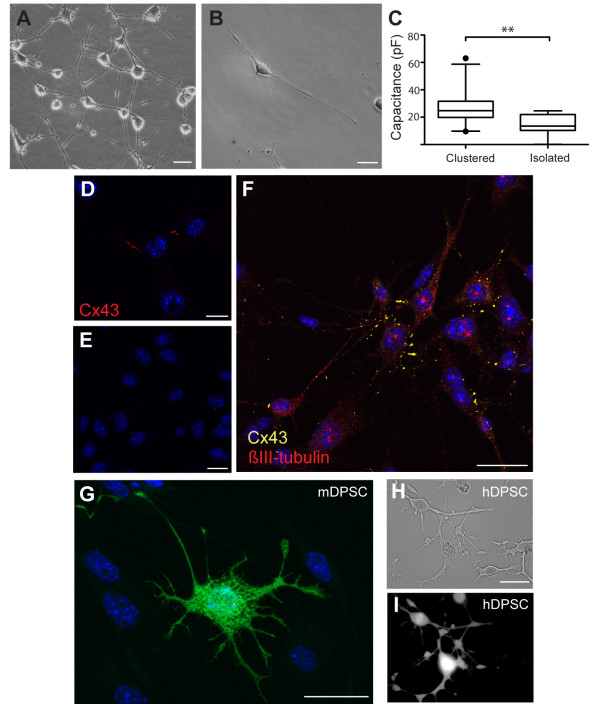
Network connectivity of differentiated mDPSC. Representative images of differentiated mDPSC in a cluster of many cells (A) and as an isolated unit (B). C) Capacitance of clustered cells (n = 23) was significantly greater than isolated cells (n = 12) measured by whole cell patch clamp analysis. IHC shows mDPSC expression of connexin 43 (Cx43) in differentiated (D) but not undifferentiated cells (E). F) Cx43 (yellow) is most highly expressed within clusters of ßIII-tubulin (red) positive differentiated mDPSC (iii). G) Image of a clustered mDPSC injected with Lucifer yellow and neurobiotin does not show any dye coupling with adjacent cells. Lucifer yellow injection into a clustered differentiated human DPSC does show dye coupling through numerous adjacent cells observed under bright field (H) and ultraviolet light (I). Scale bar = 25 μm. **P <0.01. IHC, immunohistochemistry; mDPSC, murine dental pulp stem cells.